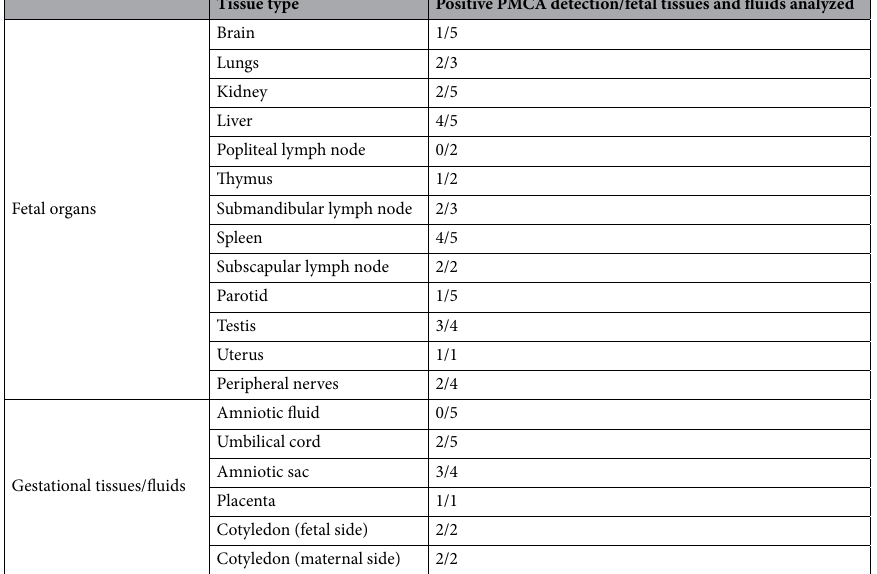
Table 2. Summary of PMCA screening in fetal and gestational tissues and fluids collected from two pregnant white-tailed deer